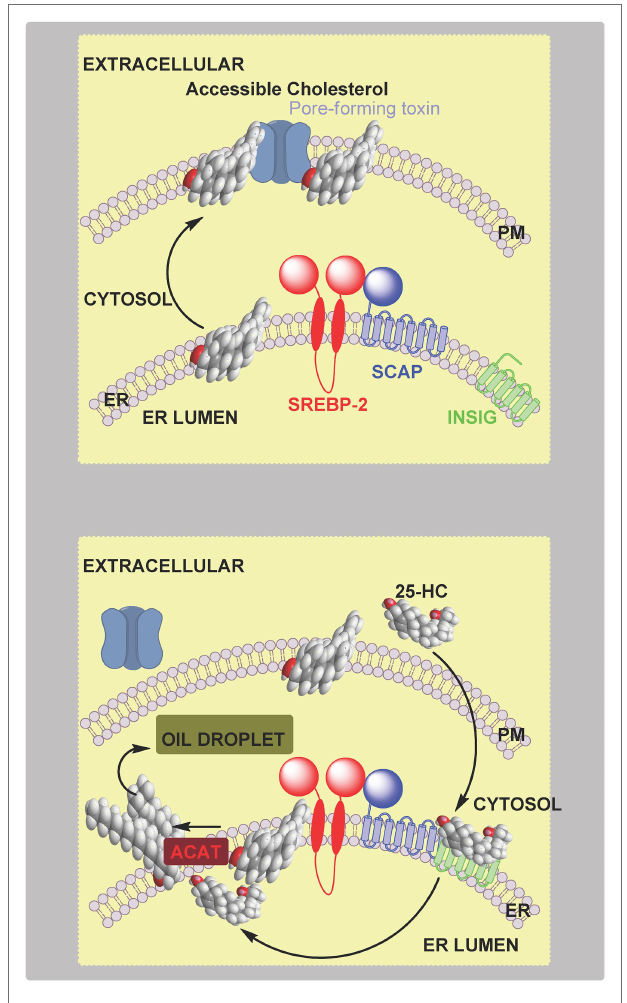
FIGURE 10 | Cartoon representation of the protection by 25-HC of macrophages and neutrophiles against pore-forming toxins. Upper panel , pore-forming toxin binds to accessible cholesterol in the plasma membrane, oligomerises and create a pore, ultimately leading to cell death. Lower panel , 25-HC generated by macrophages in response to infection rapidly crosses the cell membrane, and (i) inhibits SREBP-2 processing leading to reduced cholesterol synthesis and (ii) activates ACAT/SOAT and cholesterol esterification, in combination leading to a reduction in plasma membrane accessible cholesterol. The consequence is reduced binding of pore-forming toxins to the plasma membrane and protection of the cell. 25-HC can also activate LXR to enhance cholesterol export and can encourage the ubiquitination and degradation of HMG-CoA reductase to repress cholesterol synthesis (not